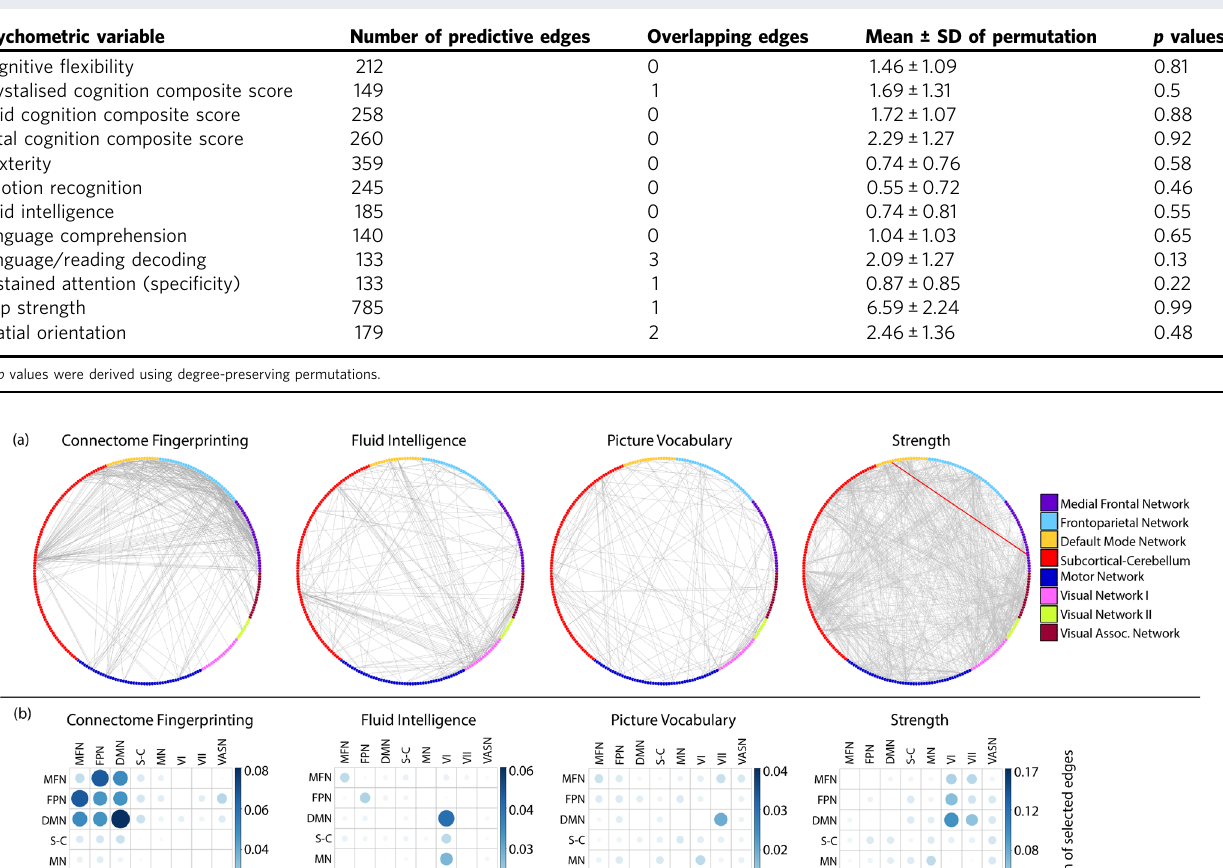
Table 2 Overlap between highly discriminatory and predictive edges.